Question: What kind of plot is shown here?
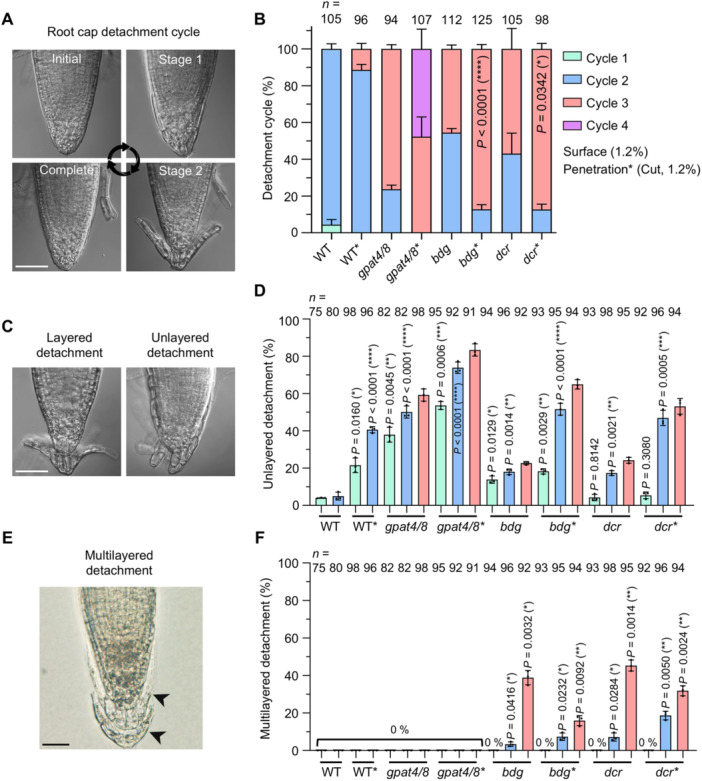
Answer: bar